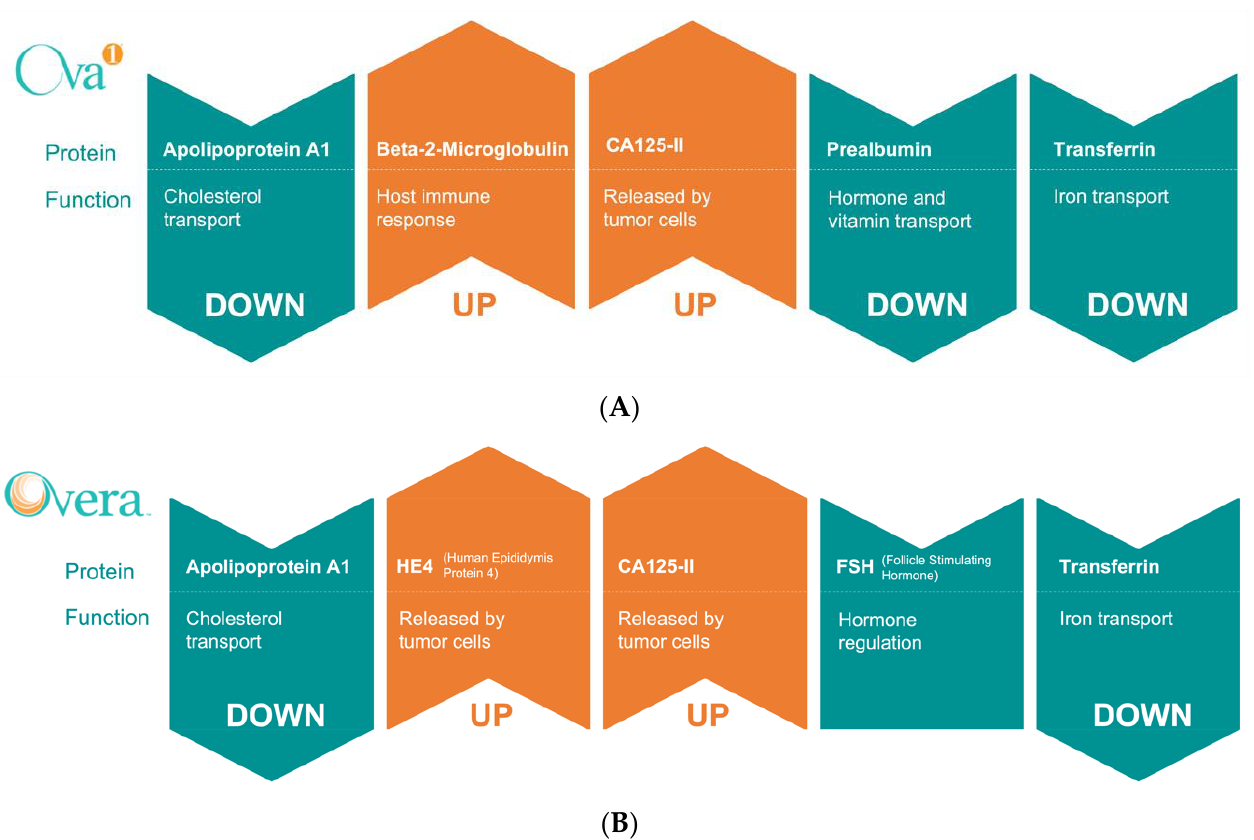
Figure 6. Biomarkers used in the OVA1 ® and Overa ® assays developed by Aspira Women’s Health Inc. ( A ) The OVA1 ® assay incorporates TVU findings and menopausal status with changes in serum proteins ApoA-1, B2M, CA125, Transthyretin (Prealbumin) and Transferrin. ( B ) The Overa ®